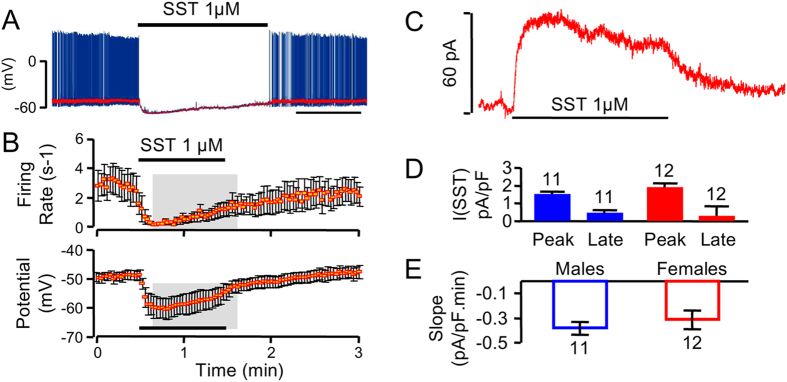
SST rapidly silences GHRH neuron activity.(A) Representative trace showing silencing of an identified GHRH neuron following local pressure ejection of somatostatin (SST). (B) Mean effects of SST treatment on spontaneous action potential firing (top) and resting potential amplitude (bottom) in GHRH neurons from male animals (n = 7). Data are averages of 2 sec bins. Statistically significant differences versus control (before SST application) are highlighted by the white area (P < 0.05, paired Student’s t test). (C) 5 min SST exposure induced an outward current in a GHRH neuron held at −50 mV. (D) Mean SST-induced current densities in GHRH neurons at the onset (peak) and end (late) of 1 μM SST ejections. Males are shown in blue and females in red. (E) As for (D) but mean decay rates of the SST-induced current densities.